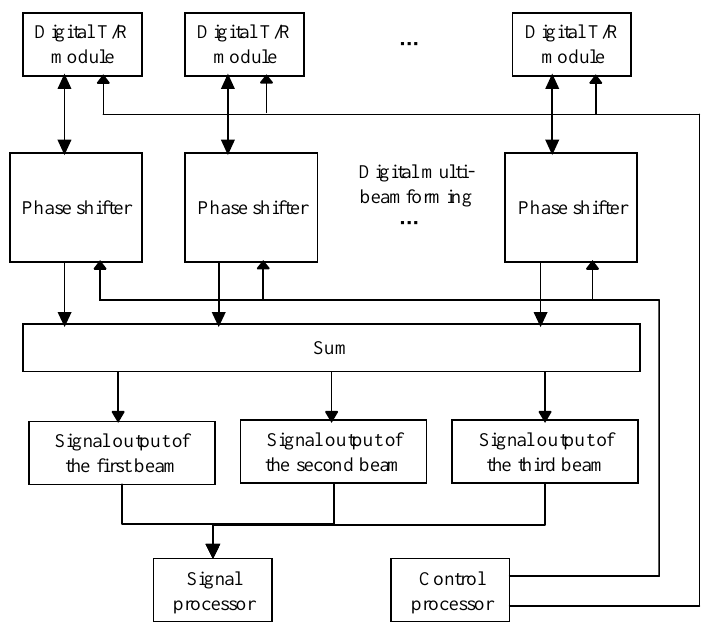
Figure 2. Reception of digital multi-beamforming.